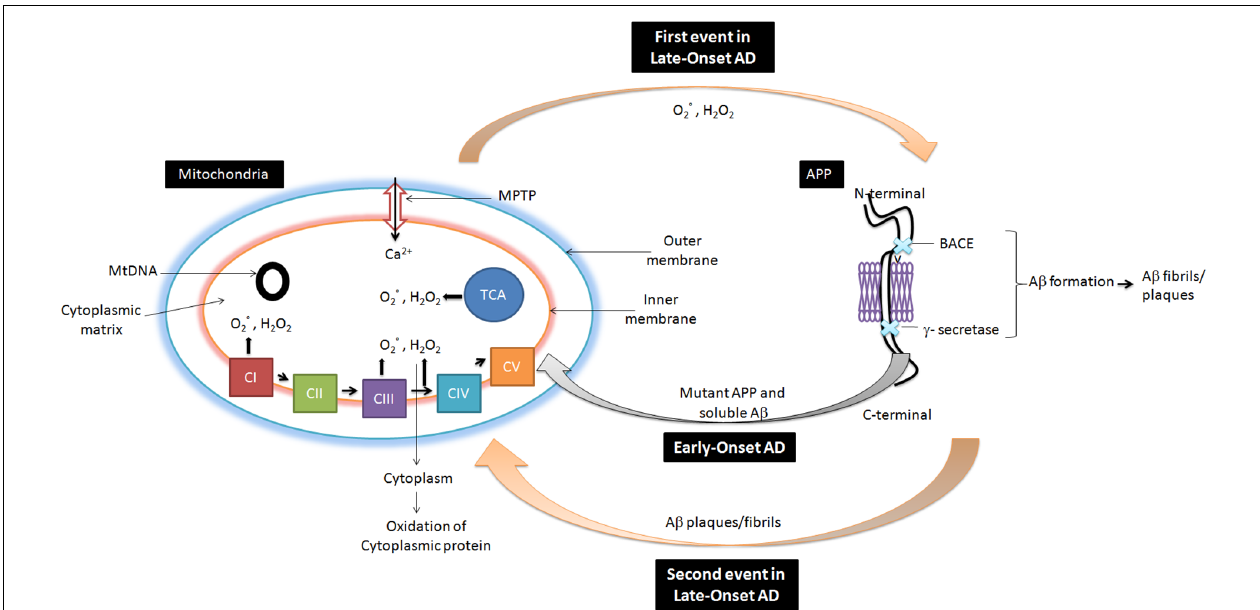
FIGURE 2 | Role of mitochondria in AD. In early-onset AD, it is hypothesized that mitochondria leads to the generation of free radicals (O · 2 — , H 2 O 2 ), which in turn decrease cytochrome oxidase activity and inhibit cellular ATP generation. Further in late-onset AD, free generation actives BACE mediated cleavage of A b . Again A b enter into the mitochondria and induces free radicals that leads to disruptions of ETC, decrease in cytochrome oxidase activity and the inhibition of ATP which finally leads to neuronal damage and cognitive decline in